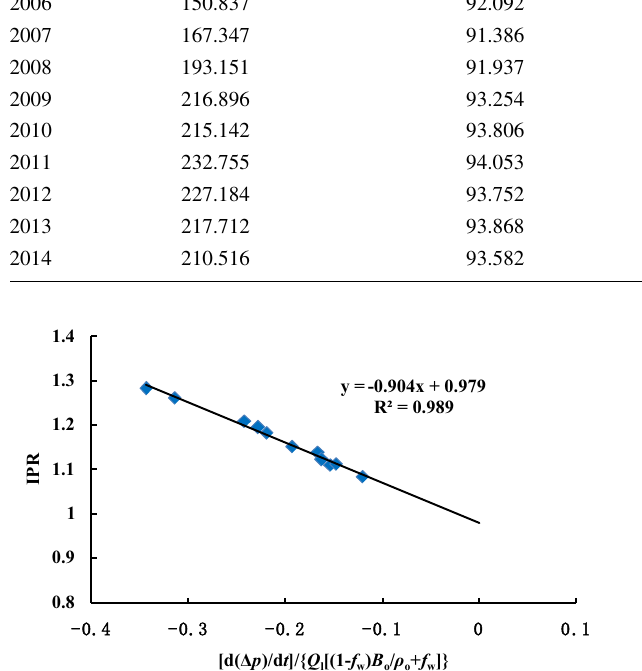
value of pressure recovery rate can be obtained. Under the condition of constant pressure variation, the water cut decreases with the increase in injection–production ratio.